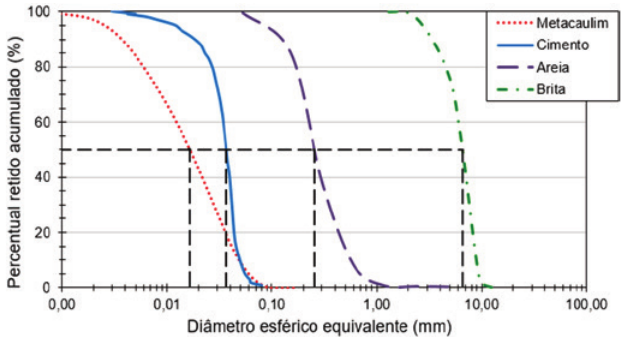
Distribuição granulométrica das